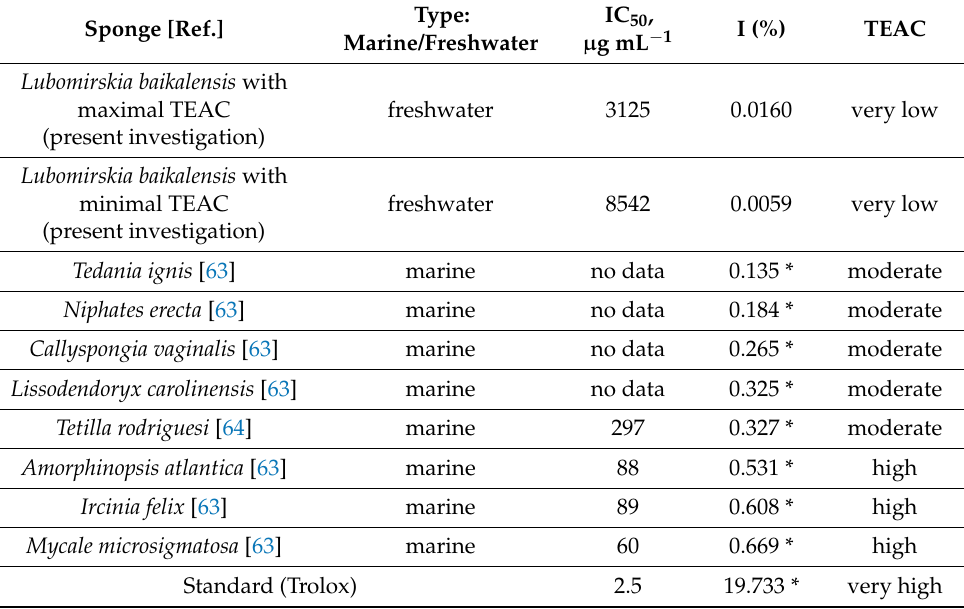
Table 4. ABTS • + antioxidant activity for some marine sponges in comparison with freshwater Lake Baikal sponge Lubomirskia baikalensis and with